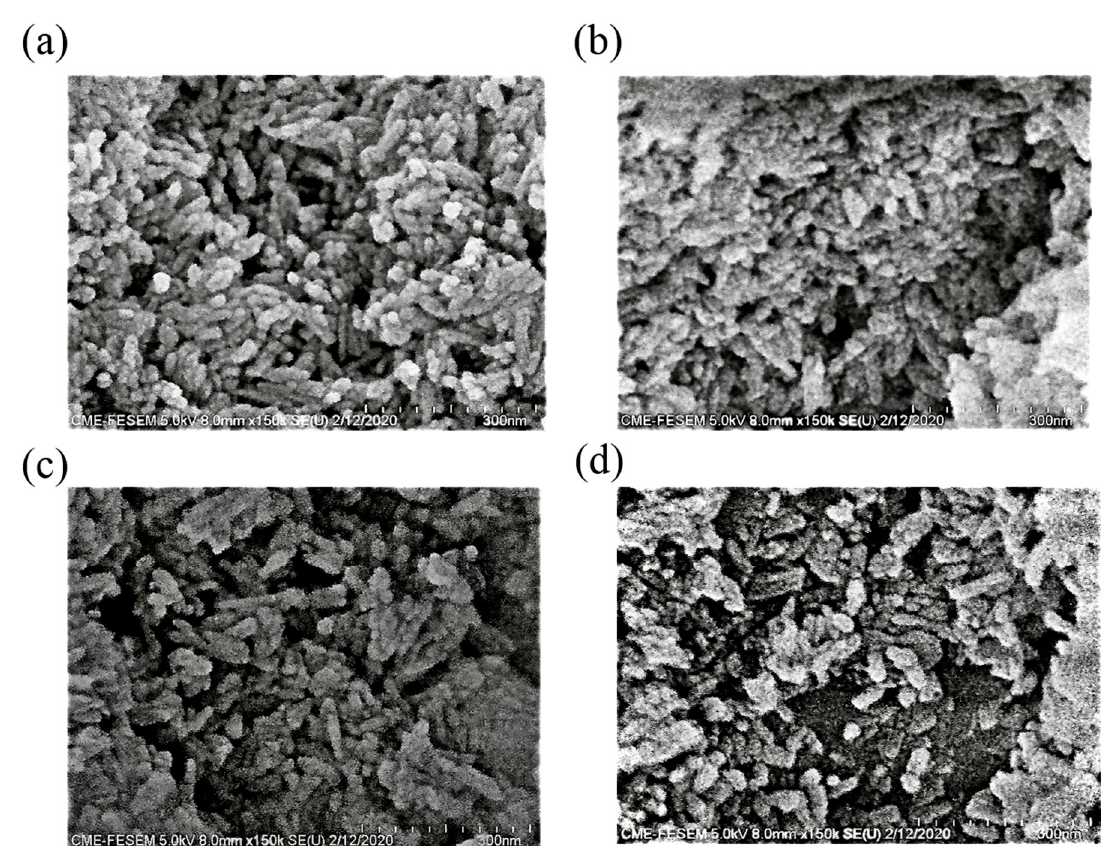
Figure 2. Scanning electron microscopy (SEM) micrograph of un-sintered ( a ) HA, and the ( b ) 0.1 wt.% r-GO/HA, ( c ) 1 wt.% r-GO/HA, ( d ) and 5 wt.% r-GO/HA nanopowders. Table 1. Geometrical and physical properties of HA and r-GO/HA NCPs. r-GO